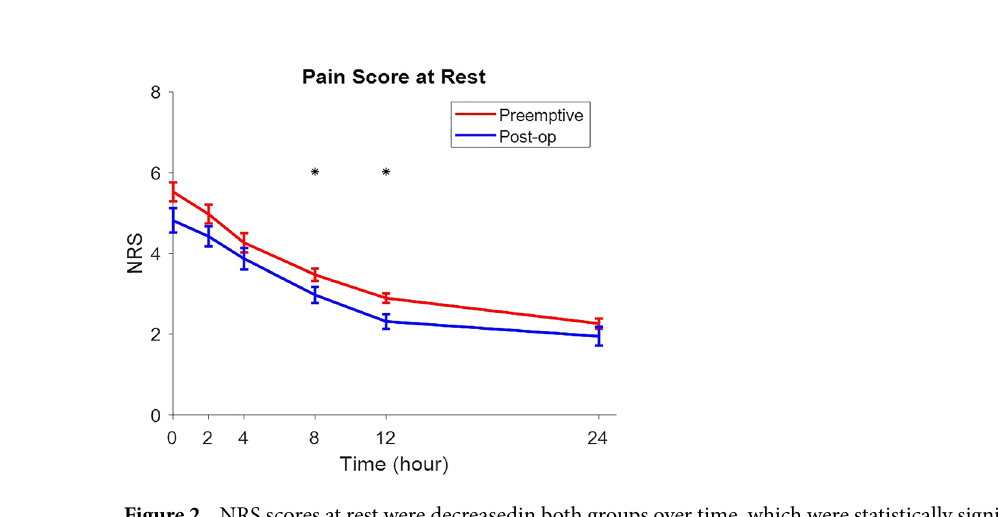
Figure 2. NRS scores at rest were decreasedin both groups over time, which were statistically significant in 8 and 12 h after the operation ( p value = 0.04 and = 0.00 respectively) (Fig. 2).